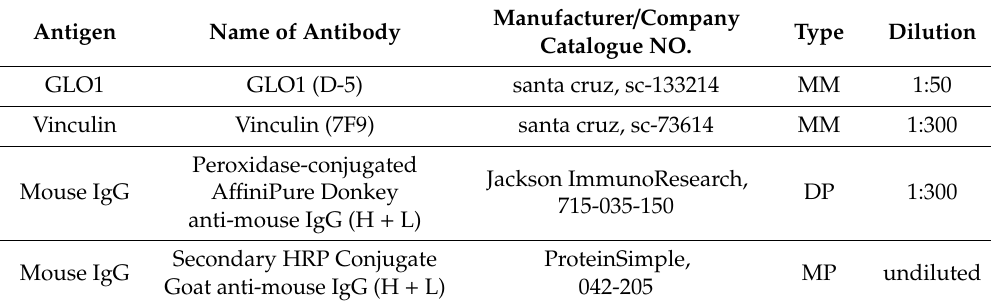
Table 1. List of primary and secondary antibodies used for the Simple Western ™ method. Antigen Name of Antibody